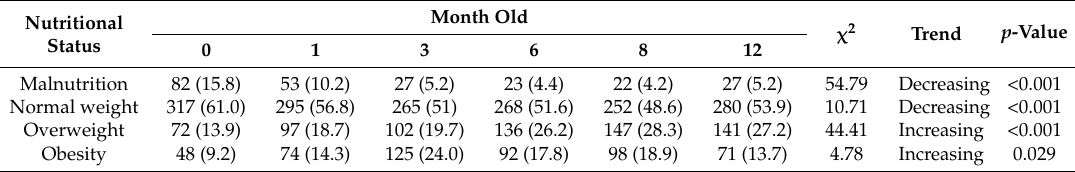
Table 2. Nutritional status of 0–12 months old infants among different time points 1 (According to longitudinal community-based retrospective birth cohort study conducted in Changsha in 2013–2014). Month Nutritional Status